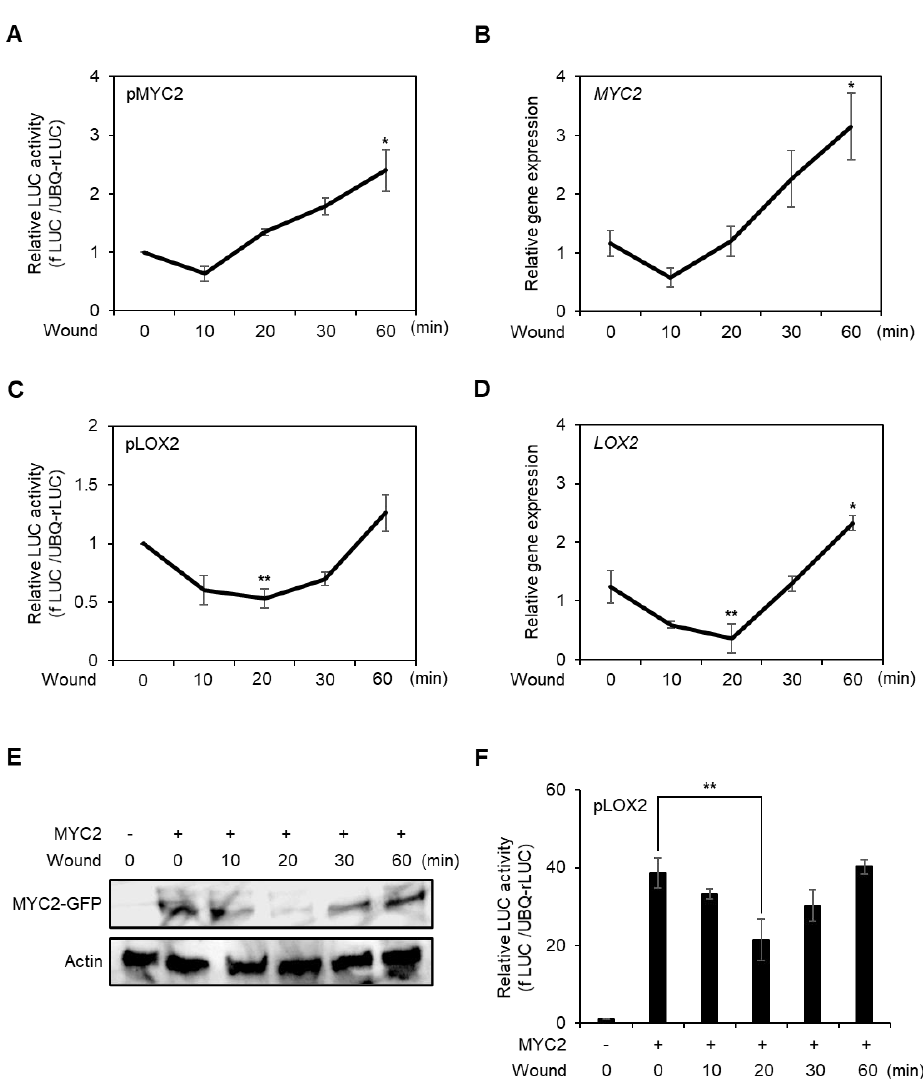
Figure 3. Analysis of promoter activity, gene expression, and protein stability of MYC2 during the early stage of wounding in protoplasts. Promoter activity of MYC2 ( A ) and LOX2 ( C ) in the early stage of wounded protoplast. fLUC -conjugated MYC2 and LOX2 promoters were respectively transfected to AMPs and incubated for 6 h. Vortex-induced wounding was performed, and the promoter activity was determined in a time-dependent manner. UBQ - rLUC was used as an expression control. Values are means ± SE of three repeats: * p < 0.01 and ** p < 0.001. AMPs were incubated for 4 h without transfection, wounded by vortex, and incubated for the designated time points. Total RNA was isolated from the AMPs and RT-qPCR was carried out with gene-specific primers of MYC2 ( B ) and LOX2 ( D ). Actin2 was used as an expression control. Values are means ± SE of three repeats: * p < 0.01 and ** p < 0.001. ( E ) Analysis of MYC2 protein stability in wounded protoplasts. 35S promoter-driven C-terminal GFP -conjugated MYC2 was transfected and incubated for 10 h. The protoplasts were wounded and incubated for designated time points and harvested. MYC2 proteins were detected using an anti-GFP antibody. Actin was used as a loading control. ( F ) Transient promoter activity of LOX2 with MYC2 effector in wounded protoplast. fLUC -conjugated LOX2 was expressed with or without MYC2 effector and incubated for 60 min. The LOX2 promoter activity was determined in a time-dependent manner. UBQ - rLUC was used as an expression control. Values are means ± SE of three repeats: ** p <